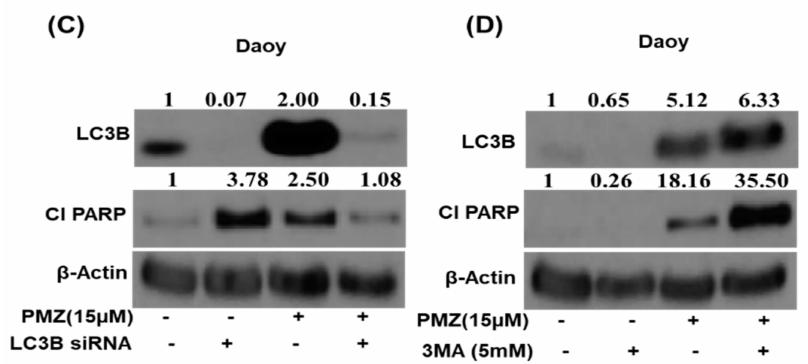
Figure 7. Pimozide induces autophagy-mediated apoptosis. ( A , C ) Approximately 0.2 million U-87 MG and Daoy cells were treated with LC3B siRNA followed with the treatment of 10 µ M and 15 µ M pimozide for 48h. Levels of LC3B and cleaved PARP were evaluated by Western blotting. β -actin was used as a loading control. ( B , D ) U-87 MG and Daoy cells were pretreated with 5 mM 3-methyladenine for 3 h. Following the treatment of cells with an autophagy inhibitor, cells were treated with 10 µ M and 15 µ M pimozide for 48 h. The expression of LC3B and cleaved PARP was evaluated using Western blot analysis. β -actin was used as a loading control. The figure is a representation of at least three independent experiments.